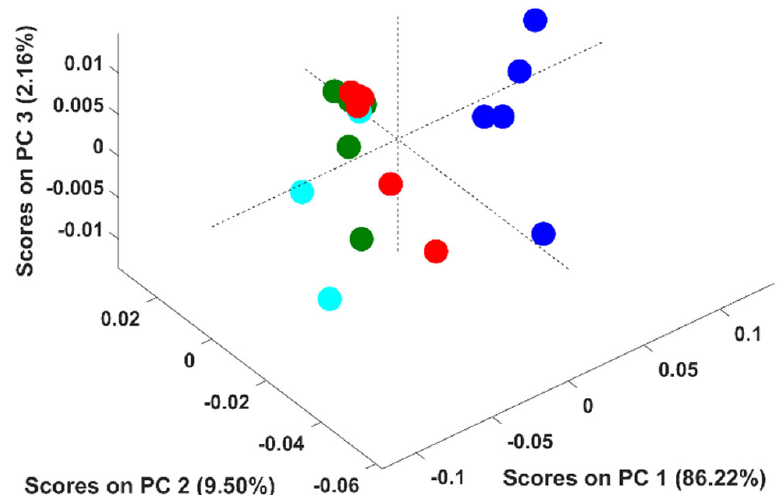
Figure 4. Scores plot of the first three principal components (PCs) of the PCA model. Legend: • arabica; • samples adulterated with coffee husks; • samples adulterated with rice; • samples adulterated with rice and coffee husks.